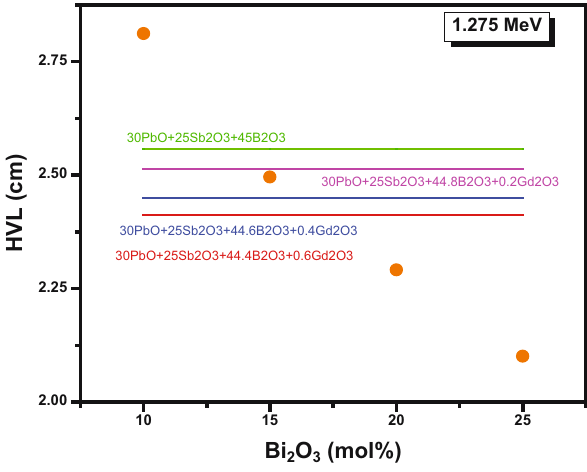
Figure 9: Comparison between the HVL for the prepared Bi 2 O 3 – PbO – CdO – B 2 O 3 glass system with